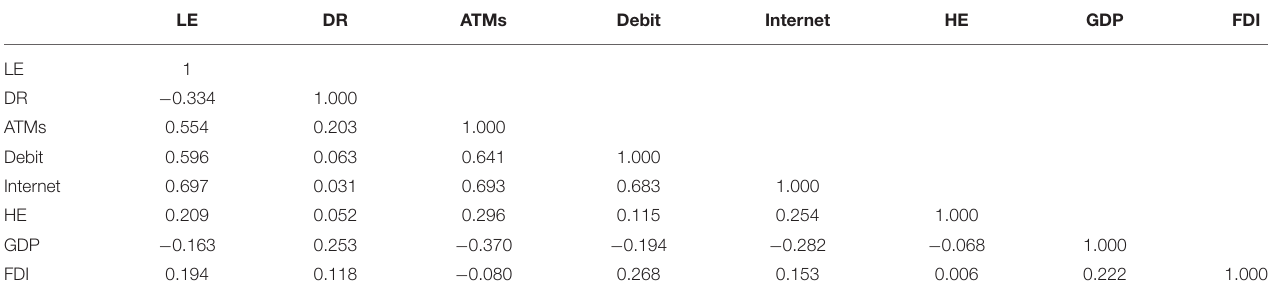
TABLE 3 | Matrix of correlations.